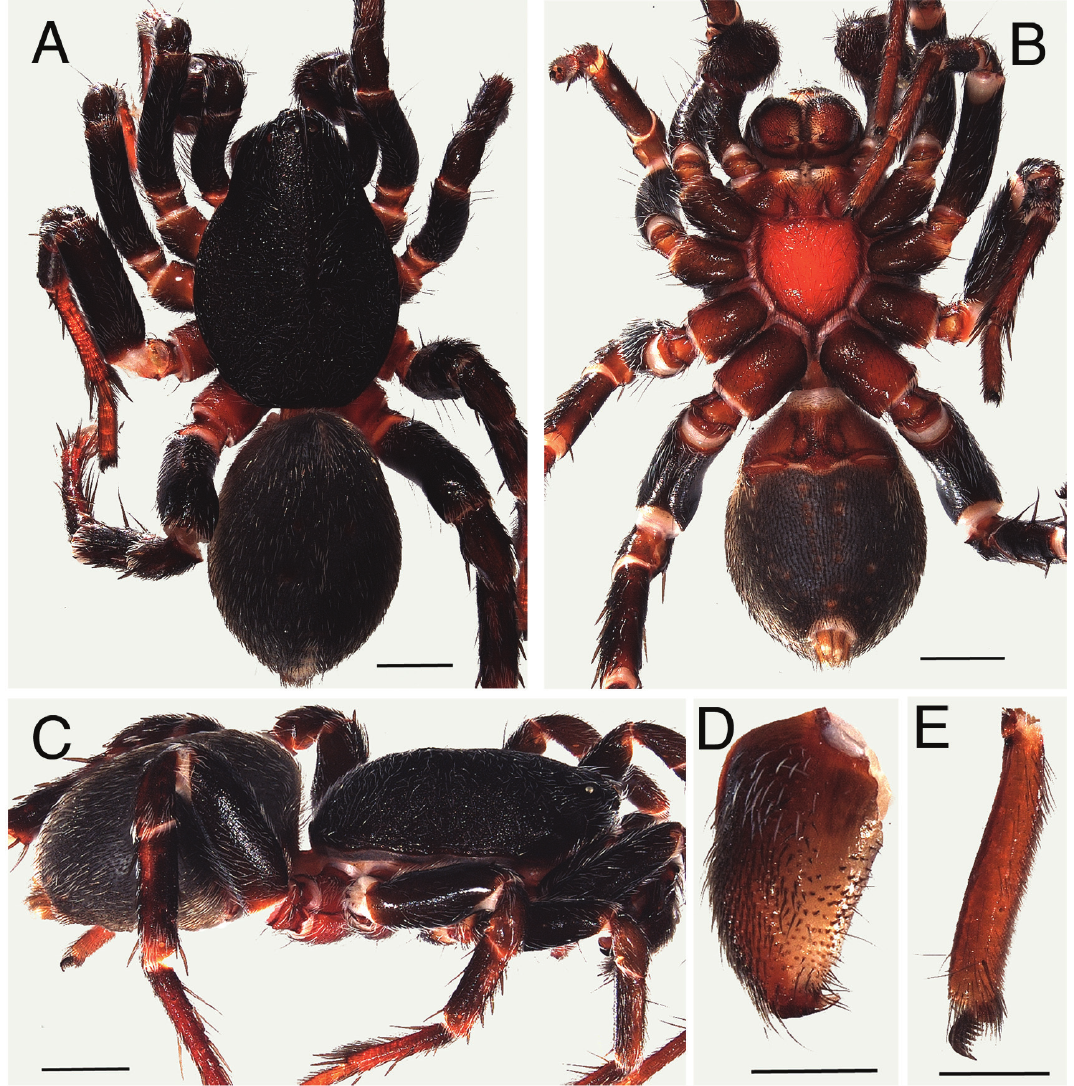
Fig. 11. Palindroma obmoimiombo gen. et sp. nov., paratype, ♂ (MRAC 241634). A . Habitus, dorsal view. B . Idem, ventral view. C . Idem, lateral view. D . Left chelicera, ventral view, showing mesal field of spinules. E . Tarsus 4, retrolateral view. Scale bars: A–C = 1 mm, D–E = 0.5